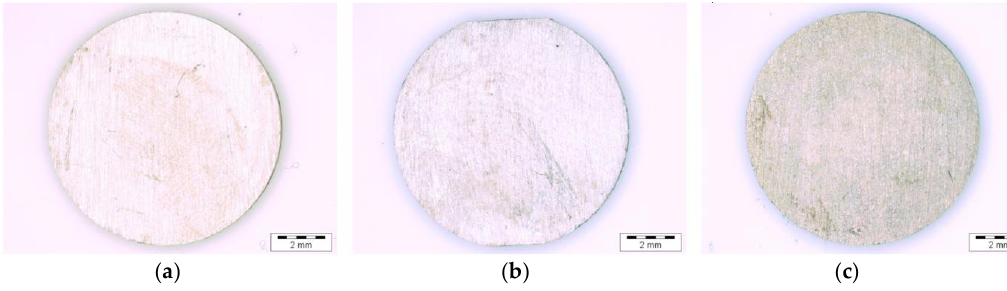
Figure 1. Stereo microscope images of representative samples X03 ( a ), Z5 ( b ) and ZX50 ( c ) before immersion in SBF.